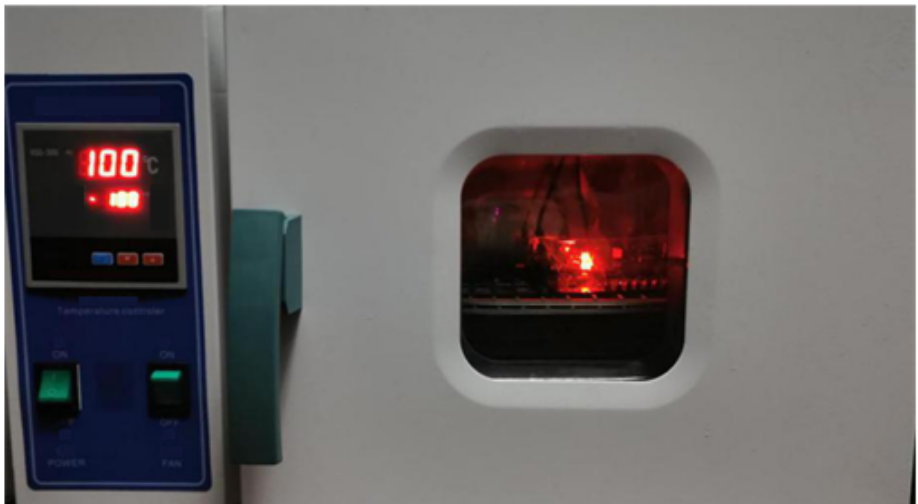
Figure 4. Operation state of the high-temperature test